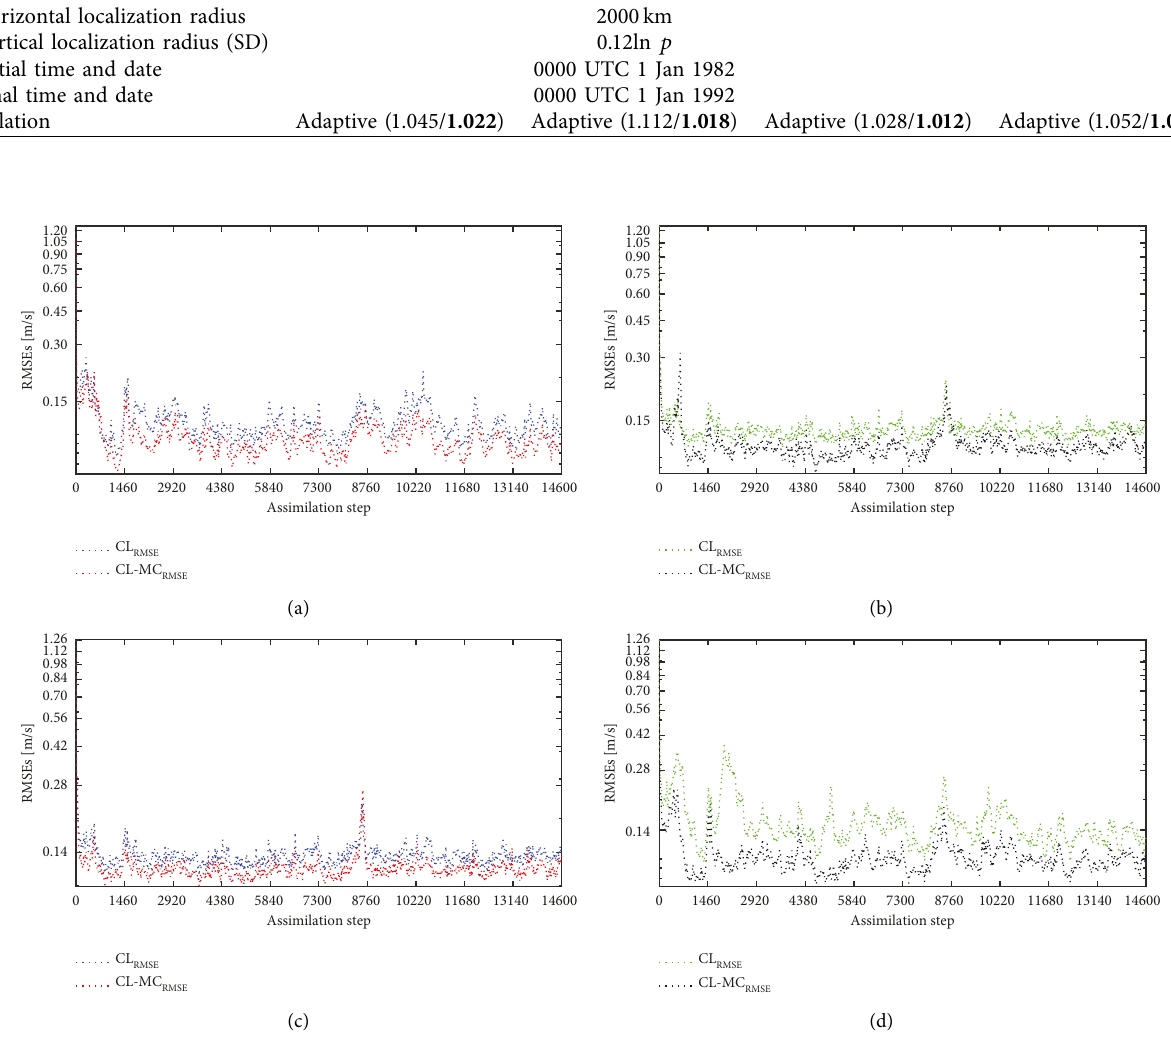
Figure 5: Time series of the RMSEs for zonal wind (ms − 1 ) at the fourth model level ( ∼ 510hPa) with different ensemble sizes. (a) Ensemble size � 75. (b) Ensemble size � 100. (c) Ensemble size � 125. (d) Ensemble size � 200. Here, 14600 assimilation steps correspond to 10 years from 0000 UTC 1 January 1982 to 0000 UTC 1 January